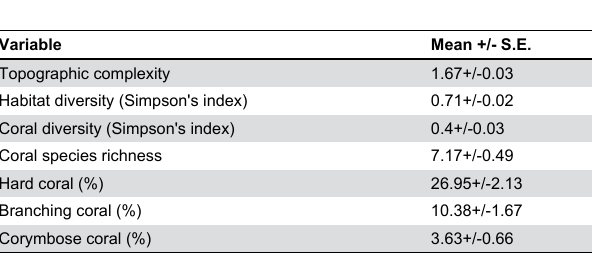
Table 1. Substrate types and hard coral growth forms recognised.